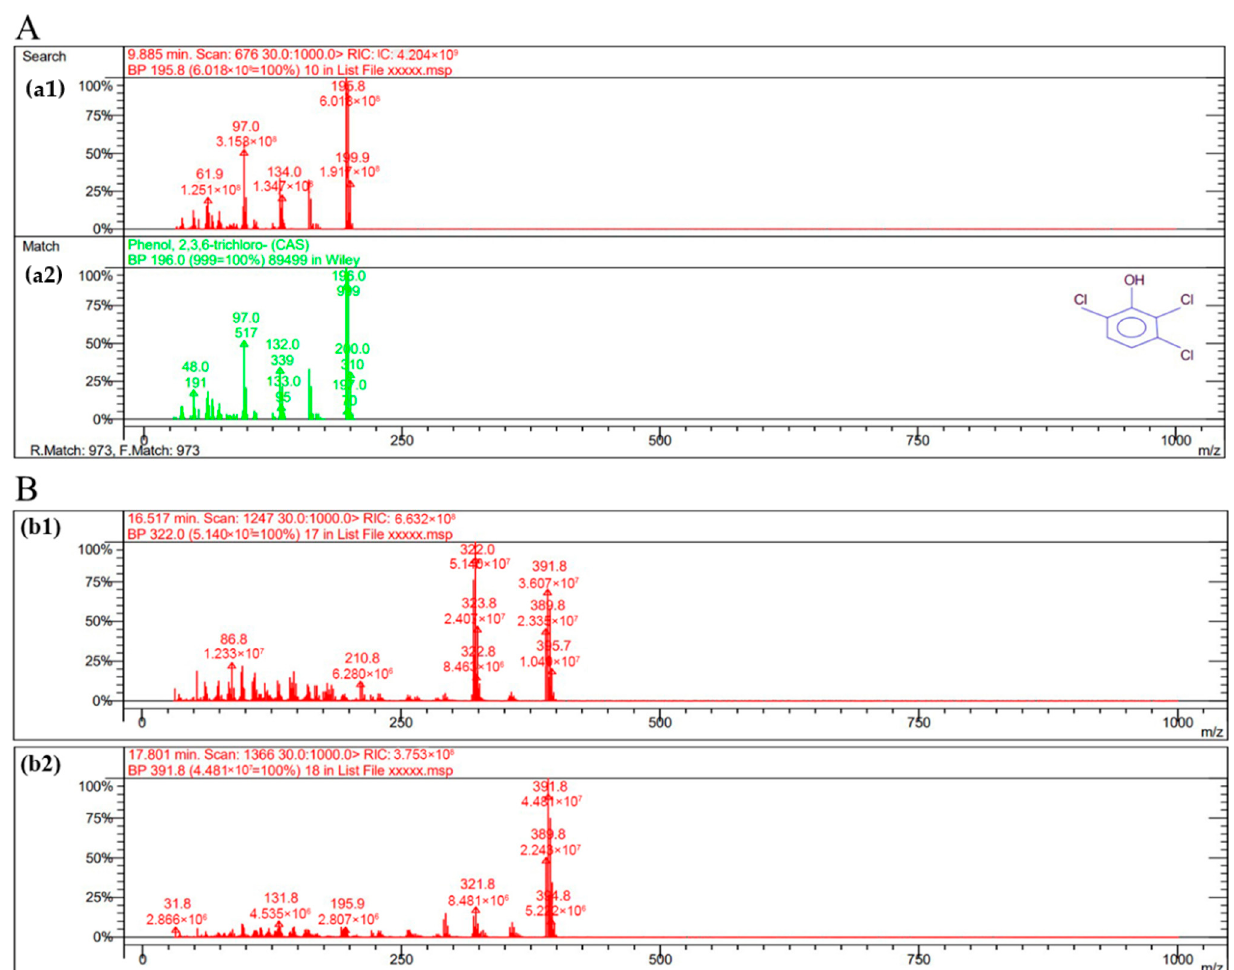
Figure 14. Mass spectrum (MS) of degradation products of 2,3,6-TCP degraded by LAC-4. ( A ) Mass spectrum of 2,3,6-TCP. ( a1 ) is the MS detection result of 2,3,6-trichlorophenol (not degraded). ( a2 ) is the database matching result. ( B ) Two intermediate products were detected by GC-MS: product I ( b1 ), which had a retention time of 16.517 min with a m / z of 391.8, and product II ( b2 ), which had a retention time of 17.801 min with a m / z of 391.8.